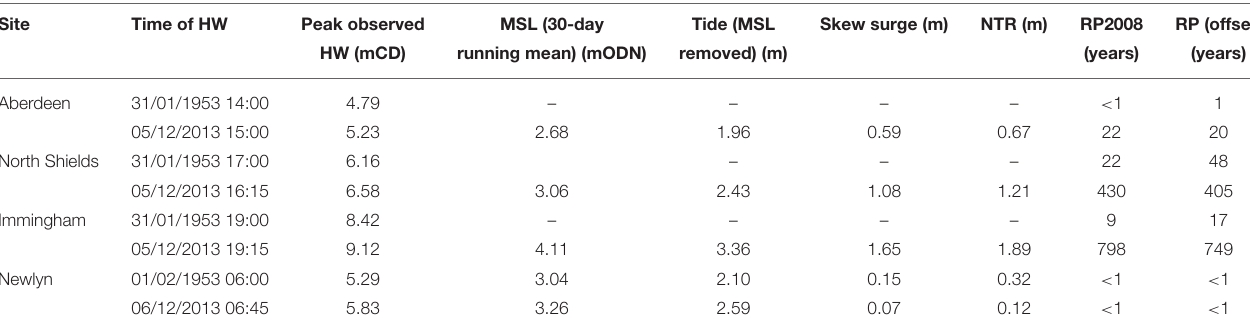
TABLE 1 | Sites with tide gauge data from the BODC for 1953 and 2013.